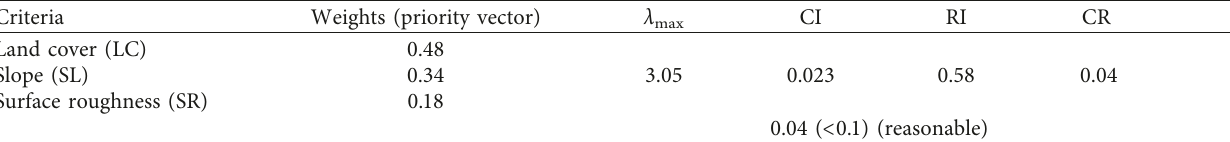
Table 4: The computed values of weights (priority vector), CI, RI, and CR for authors’ opinions.